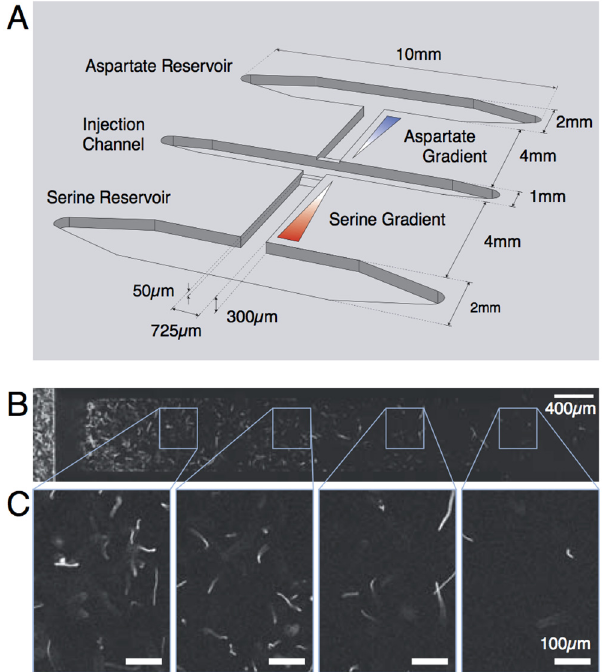
Fig 4. The experimental setup and raw images of bacteria running in the channels. A. Illustration of the microfluidic setup where bacterial speed races take place. Reservoirs were filled with the appropriate concentration of chemoattractants and let diffuse through the lateral channels so as to establish linear gradients of chemoattractants in equilibrium with the flow of motility medium applied in the injection channel. Bacteria were then inserted into the injection channel and a fraction of them climb gradients of chemoattractants in the lateral channels. B. A typical stitched fluorescence image of a channel. A sequence of 20 images (exposure time of 200ms) were superimposed and then stitched together. On the extreme left, it is shown the injection channels, where the density of bacteria is the highest, while successive positions along the lateral channel are presented moving from the left to the right of the panel. C. A zoom of the images in panel B at diverse positions along the lateral